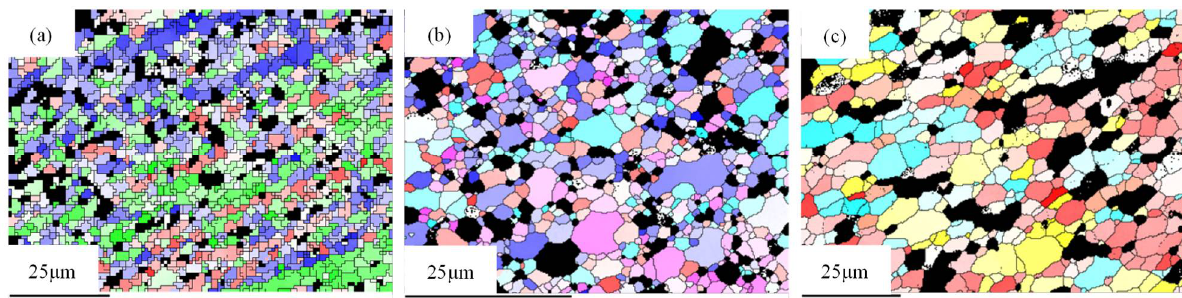
Figure 8. Chromatic aberration and distribution of grain textures at different plug rotating speeds: ( a ) 1600 rpm, ( b ) 1800 rpm and ( c ) 2000 rpm.